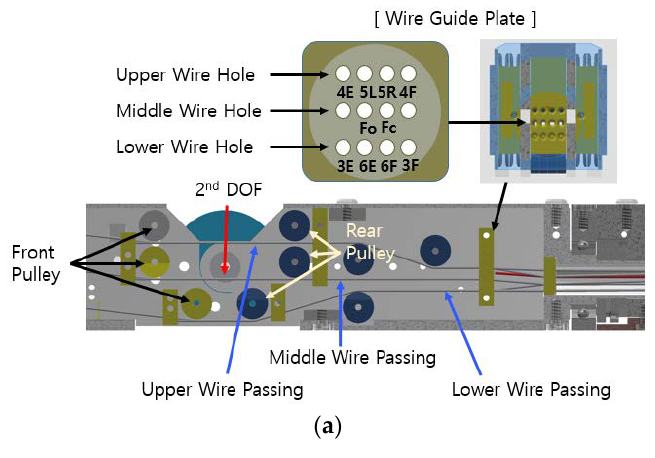
Figure 8. Cont . Figure 8. Cont .